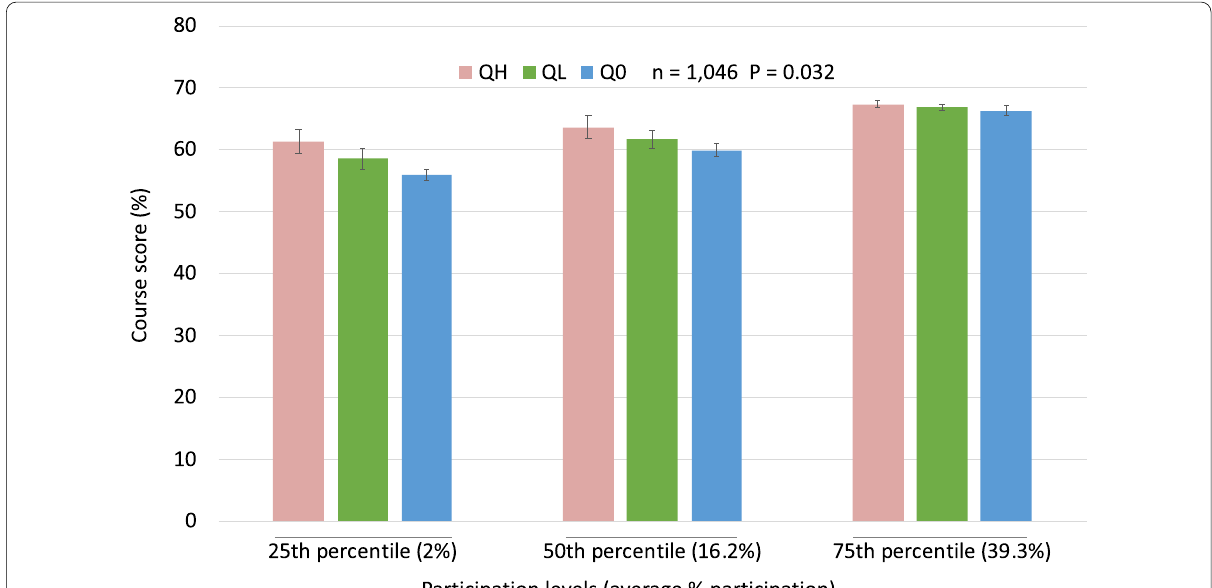
Fig. 5 The effect of quecture engagement on course score at different levels of participation. Least squares means and SE are shown at three levels of participation corresponding to the 25th percentile (2% participation), median (16.2% participation) and 75% percentile (39.3% participation) participation levels of students. Scores are combined from 3 years of study (2017–2019). QH high quecture engagers, QL low quecture engagers, Q0 students who did not engage with quectures. The increased performance of high and low quecture engagers depends on the level of participation (P 0.032) being greatest in the lowest participation group, and becoming smaller as participation levels =